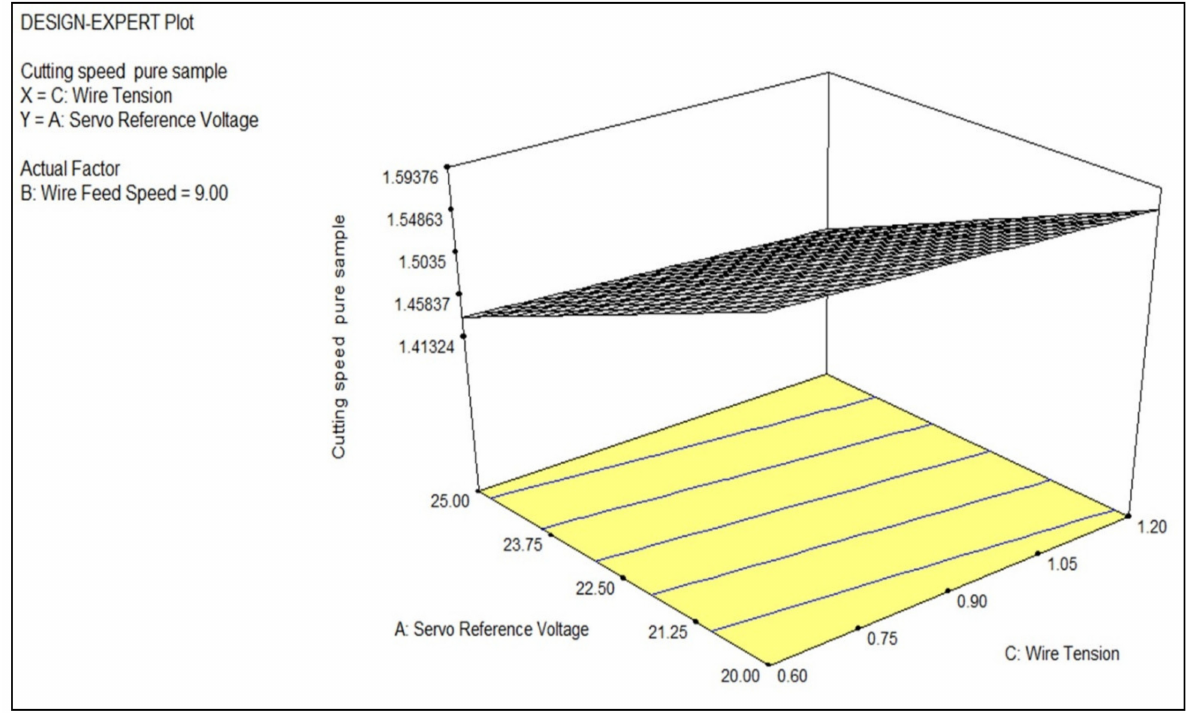
Figure 5. A 3D plot for studying the effect of the servo reference voltage and wire tension on the cutting